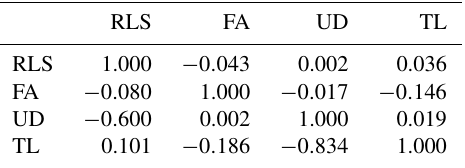
Table 6. Estimated genetics (below diagonal) and phenotypic cor- relations (above